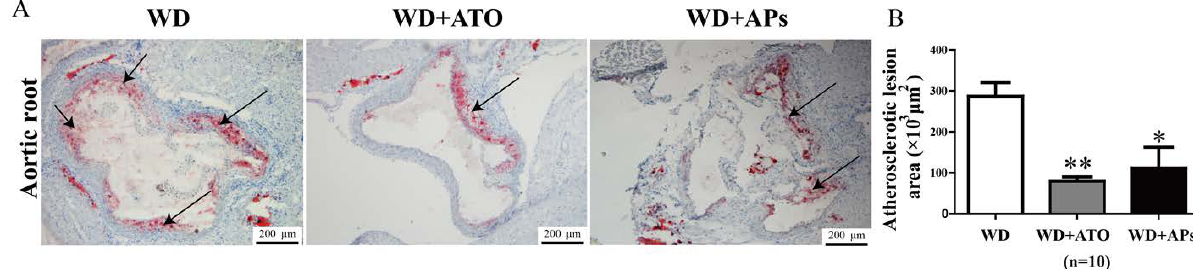
Figure 1. Quantification of atherosclerotic lesions in the aortic sinuses of ApoE −/− mice fed with a Western-type diet (WD). A : Representative images showing the atherosclerotic lesions in the aortic sinuses of ApoE −/− mice fed with WD, WD + atorvastatin (ATO) or WD + apple polyphenols (APs). The frozen aortic roots were stained with Oil Red O and counterstained with hematoxylin; B : Quantitative analysis of atherosclerotic lesion areas. The values are presented as the means ± S.E.M, n = 10 per group. * p < 0.05, ** p < 0.01 vs. WD mice (control group).